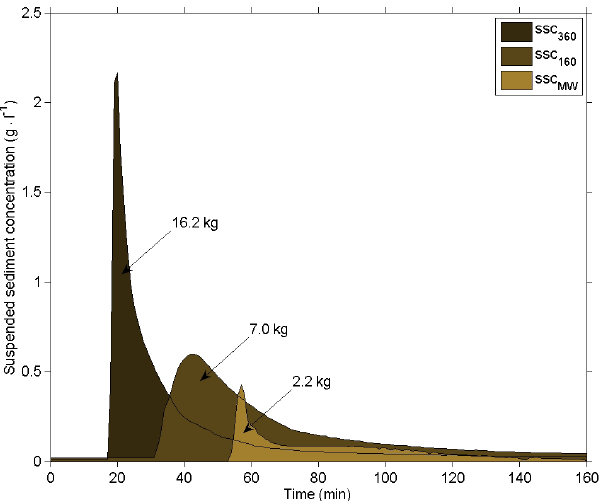
Figure 10. Hypothesis testing example 1: sediment concentrations for a flushing experiment in August 2011 at the three monitoring lo- cations. 360 is the most upstream location at 360m from the catch- ment outlet, MW. From Eder et al. (2014).